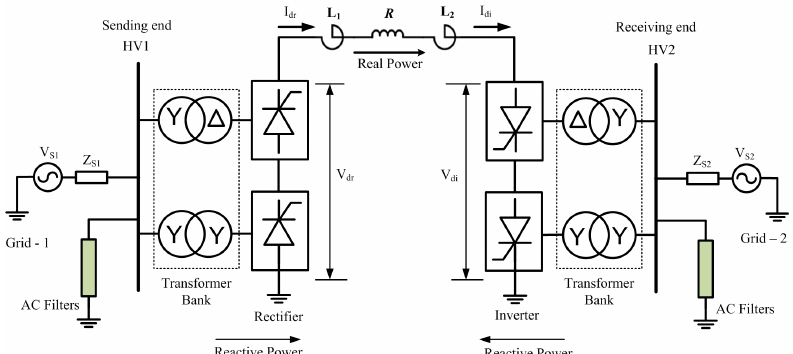
Figure 9. A LCC-HVDC system interconnecting two power